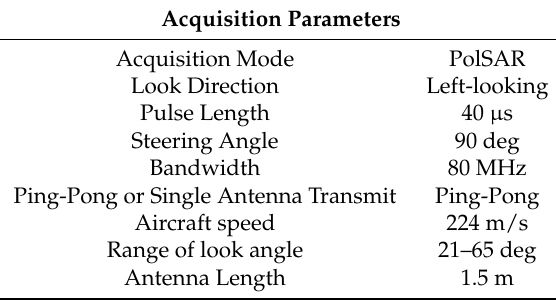
Table 2. L-band UAVSAR acquisition parameters. PolSAR: polarimetric synthetic aperture